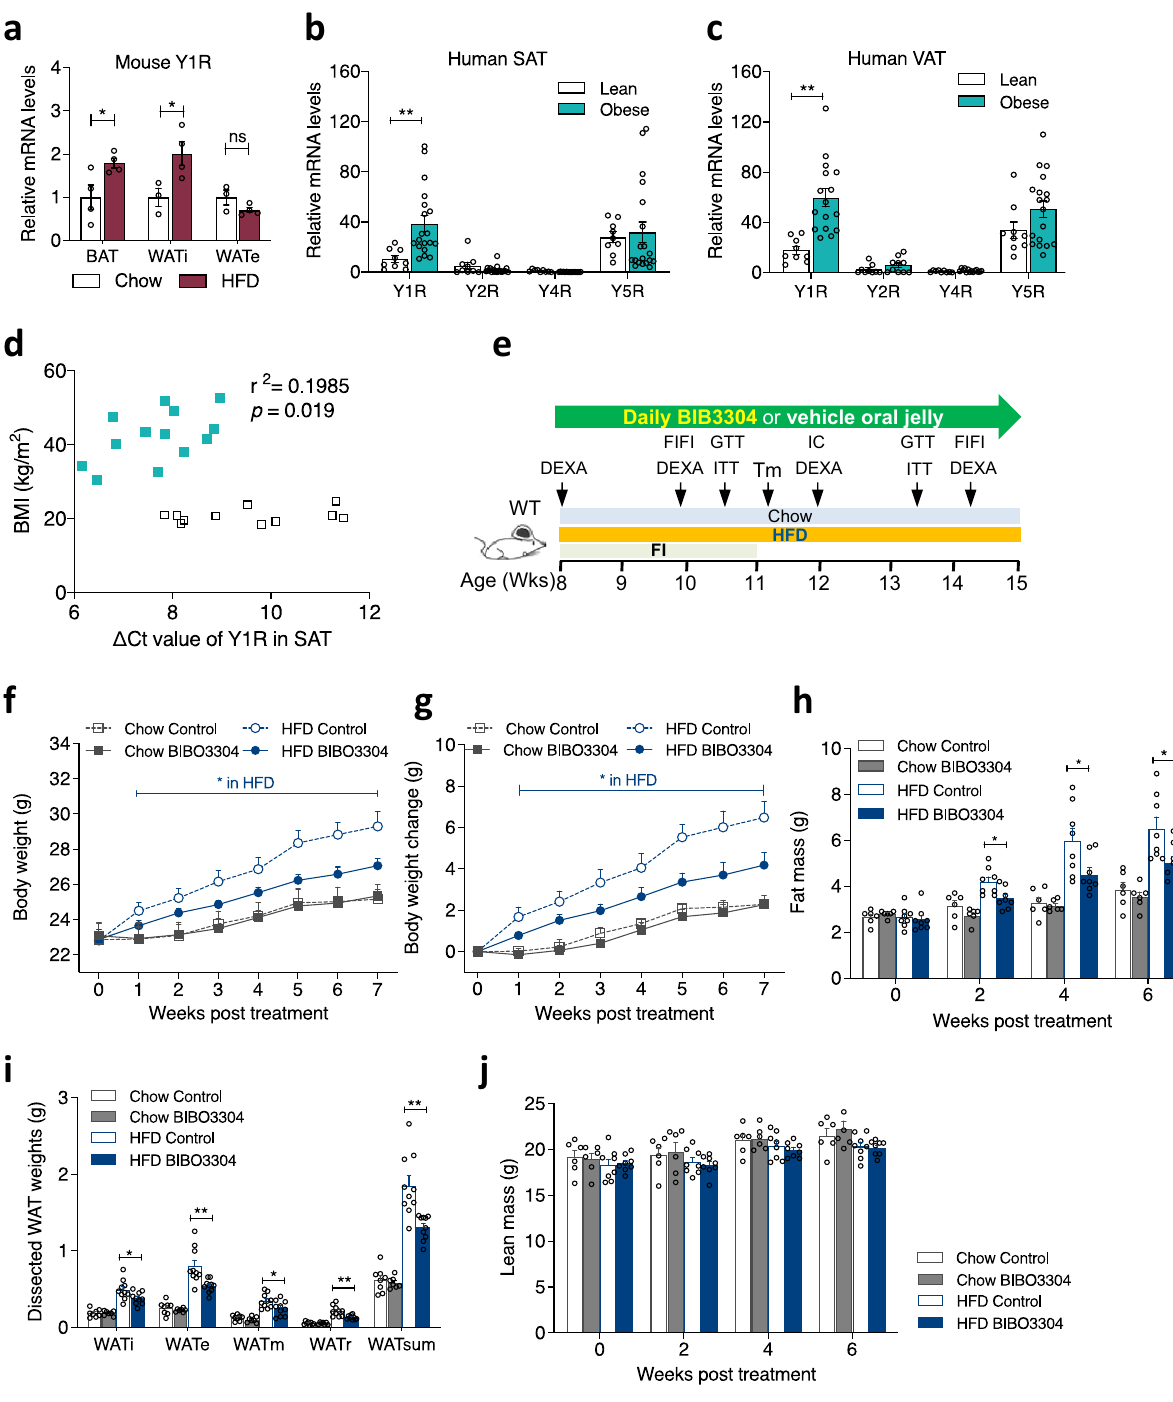
Periphery-selective Y1R antagonism increases EE . To identify which side of the energy balance equation is altered by BIBO3304 treatment, we fi rstly measured spontaneous FI in both chow- and HFD- fed mice. The average daily food intake (Fig. 2a) and cumulative FI over the fi rst 3 days of treatment did not differ (Supplementary Fig. 2a) and daily (Supplementary Fig. 2b) and cumulative FI measured from day 6 to day 21 (Fig. 2b), and at 5 weeks (Supplementary Fig. 2c) post treatment was indis- tinguishable between control and BIBO3304-treated mice on either chow or HFD feeding. Speci fi cally, control and BIBO3304- treated mice showed similar spontaneous FI during the